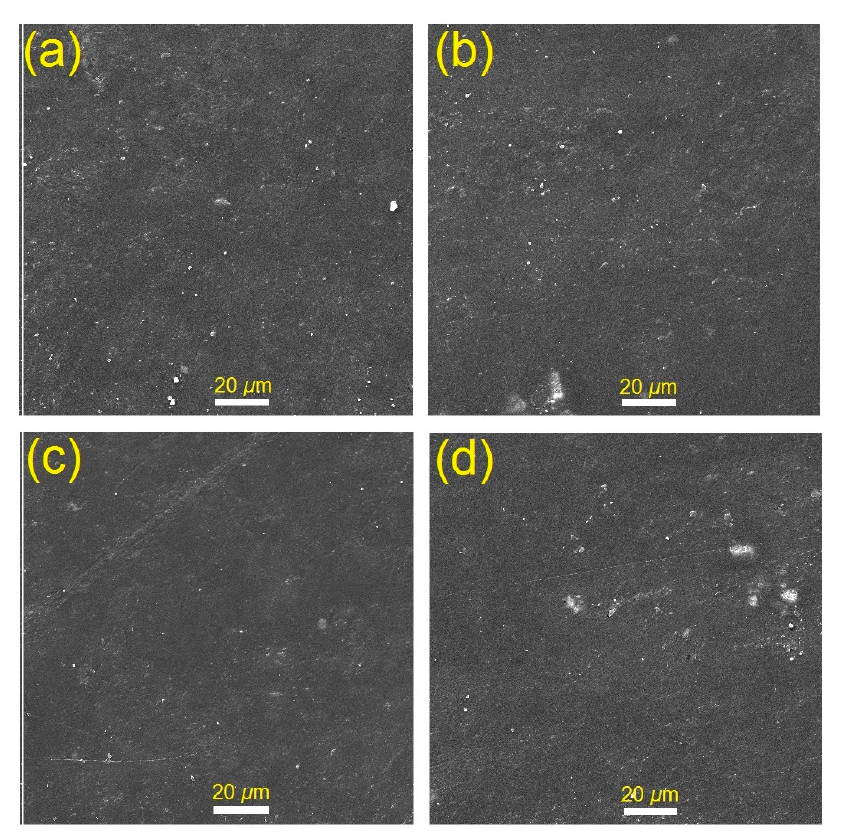
Figure 3. SEM images of LANPs-loaded GLS@PET; LA 6 ( a-d ). Table 1. Elemental compositions (wt%) of LANPs-free and LANPs-loaded GLS@PET nanocompo- sites as detected by EDXA at three positions (S 1 , S 2 and S 3 ) on the GLS@PET surfaces.